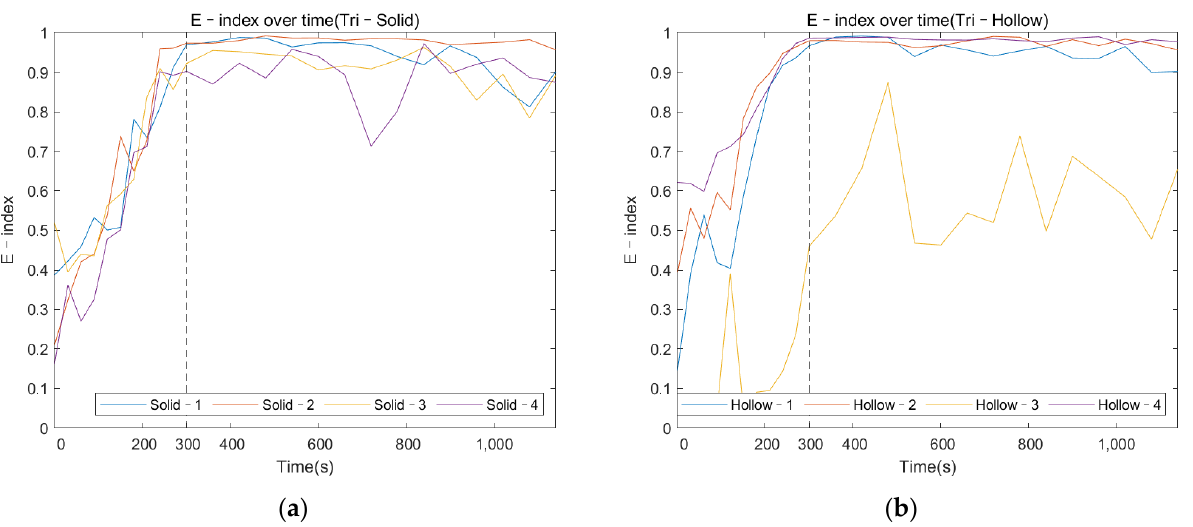
Figure 13. Variation of E–index at selected frequencies as the cure time increased for the triangular implants under ( a ) solid and ( b ) hollow conditions.